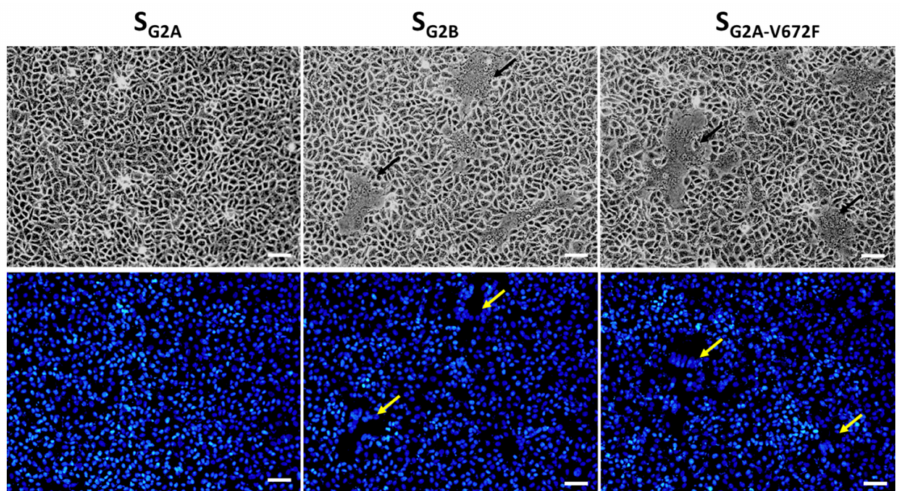
Figure 6. Syncytium formation in VeroE6 cells expressing PEDV S. VeroE6 cells were transfected with pCAGGS expressing S G2A , S G2B , and S G2A-V672F and treated with trypsin. At 24 hpt, cells were assessed for syncytium formation. Hoechst was used to stain nuclei. Arrows denote the formation of the syncytium. Scale 50 µ m.